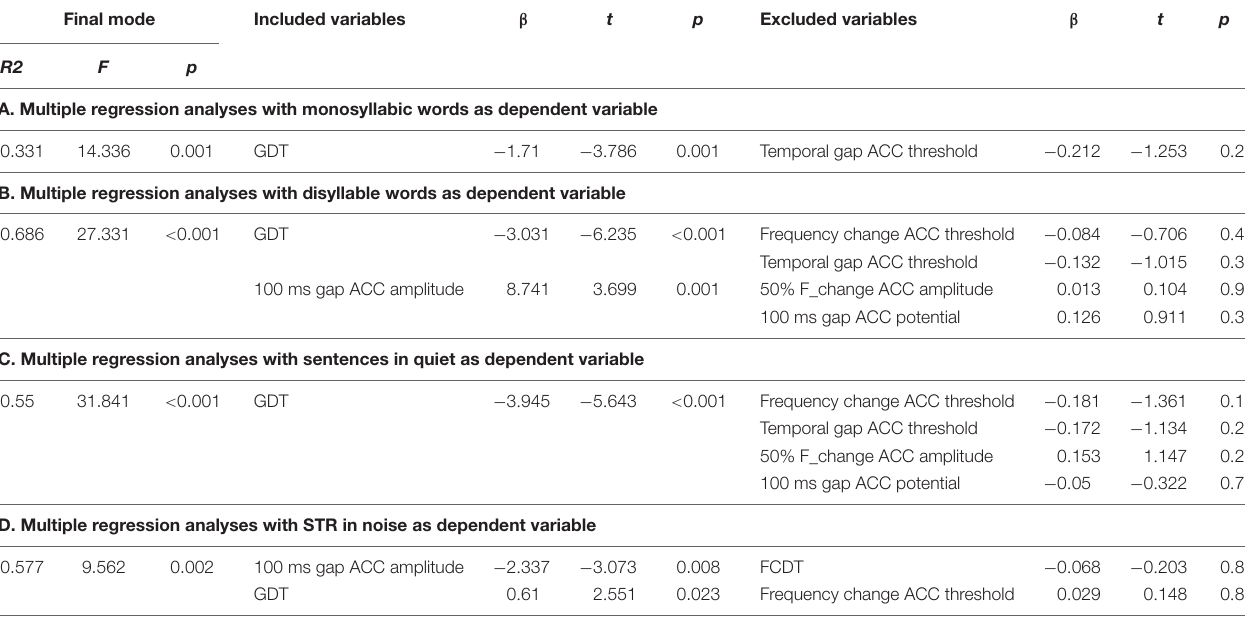
TABLE 3 | Multiple stepwise regression